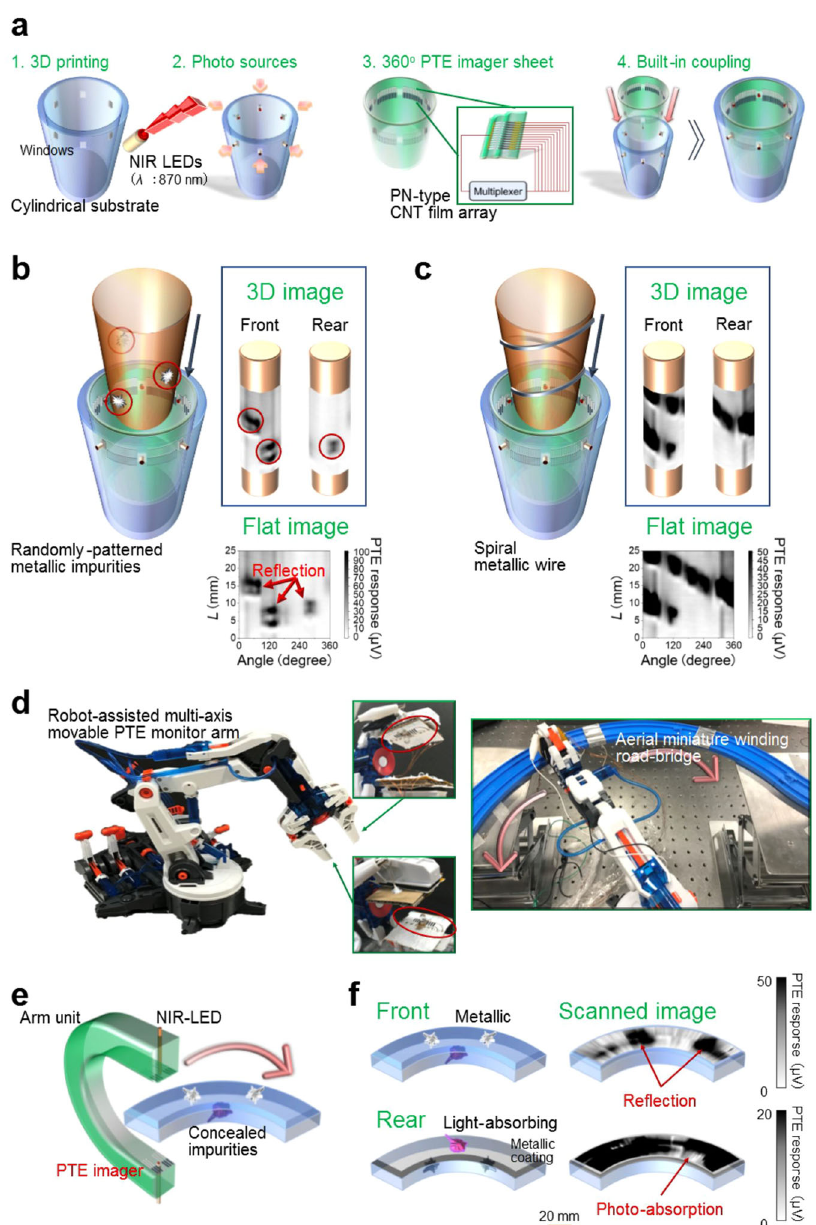
Fig. 4 Photo-source-implanted portable 360°-view three-dimensional (3D) photo-thermoelectric (PTE) imager for the robot-assisted monitoring applications. a Fabrication process of the module. Supplementary Fig. 17 and Operation of the photo-source-implanted portable 360°-view stereoscopic PTE imager of the Methods section describe the corresponding detailed operation mechanism and conditions. b Portable around-view photo-monitoring of a plastic column (in the near-infrared (NIR: λ = 870 nm) frequency region) with discretely spread metallic impurities. The impurities were visualised by omni-directionally detecting the local re fl ection signals corresponding to their locations. L : scanning direction. c Portable around-view photo-monitoring of a plastic column (in the NIR frequency region) wrapped by a spiral metallic wire assuming power-transmission line inspections. The metallic wire surface pattern was visualised by omni-directionally detecting the local re fl ection signals corresponding to its location. Here, the 360°-view stereoscopic PTE images were scanned at a speed of 10 Hz ( b , c ). d Robot-assisted photo-source-imager built-in multi-axis movable omni-directional PTE monitor arm. We employed a commercial hydraulic 5-axis movable-arm unit. The miniature model of an aerial defective winding road-bridge was set at a height of 50 cm. e Fundamental module operation mechanism. A 30- µ m-thick carbon nanotube (CNT) fi lm was utilised as the light-absorbing impurity on the road-bridge. We implanted the miniature NIR light emitting diode (NIR LED: λ = 870 nm, as in a ) and an 8-pixel freely attachable CNT- fi lm PTE photo-imager array sheet on both upper and lower arm grips. f Non-destructive unmanned remote high-speed omni-directional photo-imaging inspection of the aerial road- bridge. Defects on the aerial road-bridge: metallic impurities on the plastic front surface and the light-absorbing impurity on the metallic rear surface were visualised by collectively detecting both local re fl ection signals corresponding to the locations of the metallic impurities, and the locally attenuated re fl ection signals due to the photo-absorption corresponding to the location of the light-absorbing impurity. The multi-axis PTE monitor arm was operated at a speed of 15